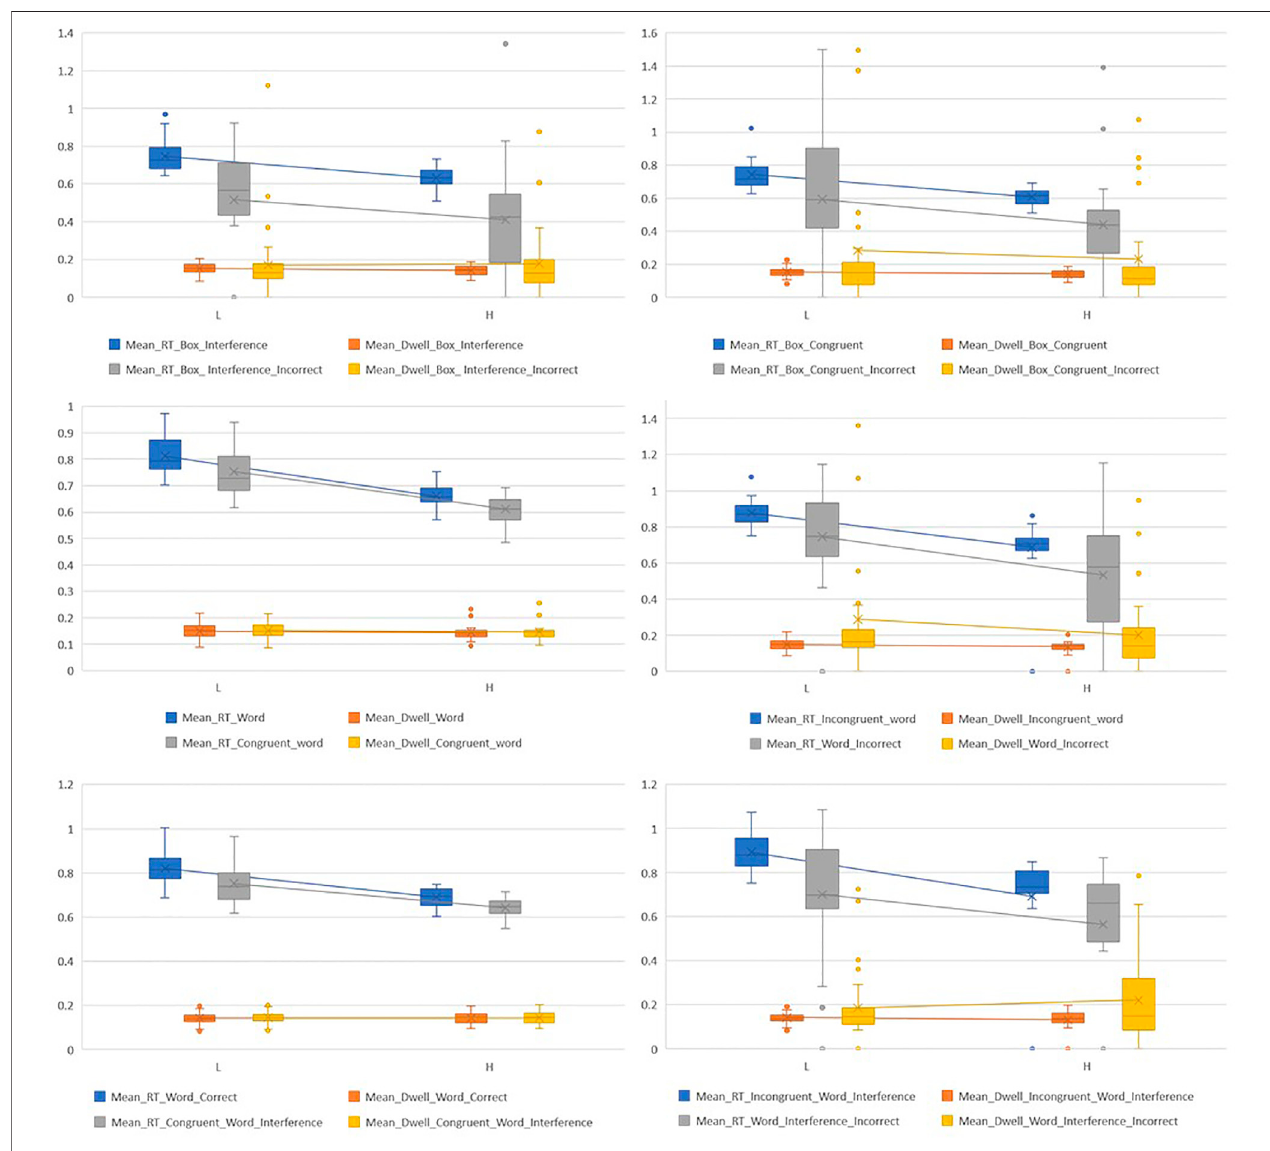
FIGURE 5 | Distribution of input variables based upon High and Low